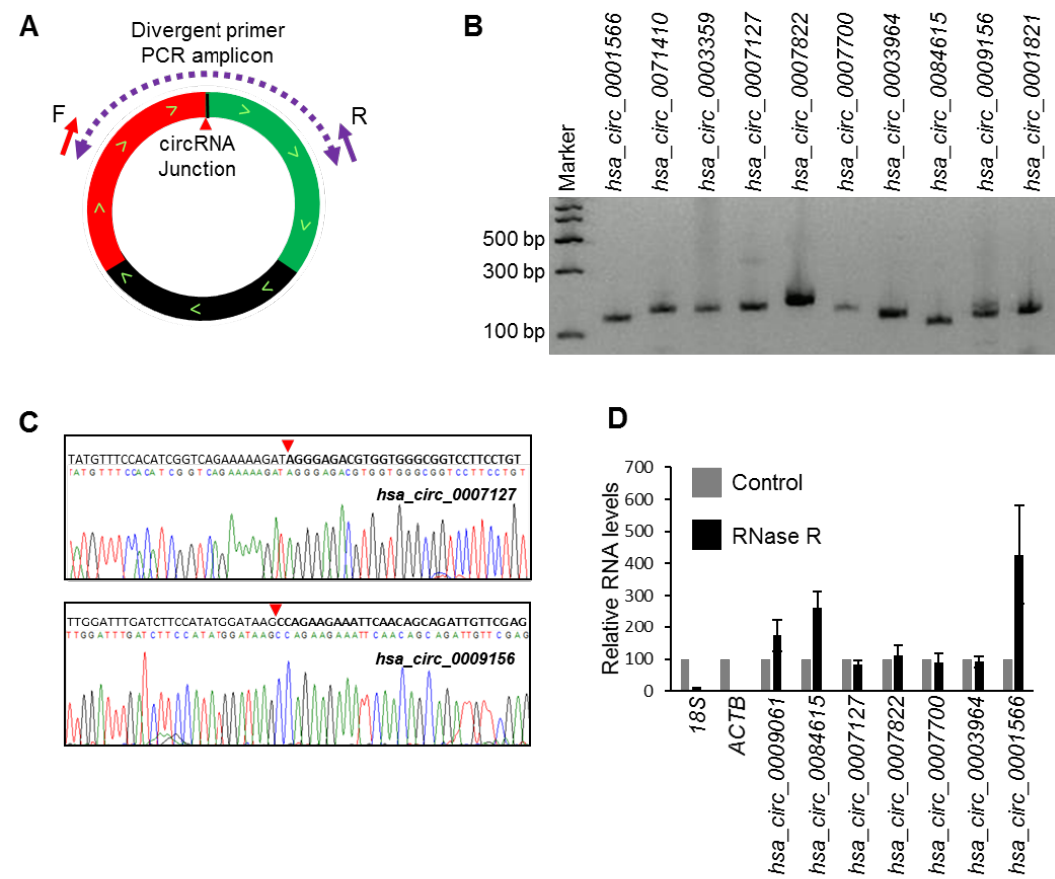
Figure 1. Validation of circRNA expression using divergent primers. ( A ) Schematic representation of the divergent primers used for detection and quantification of circRNAs. The red arrowhead represents the backsplice site. ( B ) PCR products amplified with divergent primers resolved on SYBR Gold-stained, 2% agarose gels. ( C ) Sanger sequencing of purified PCR products showing the backsplice junction sequences of mentioned circRNAs. The red arrowhead represents the backsplice site. ( D ) RT-qPCR (reverse transcription-qPCR) analysis of the resistance of circRNAs to RNase R digestion. Data represent the means ± S.E.M. from three experiments.